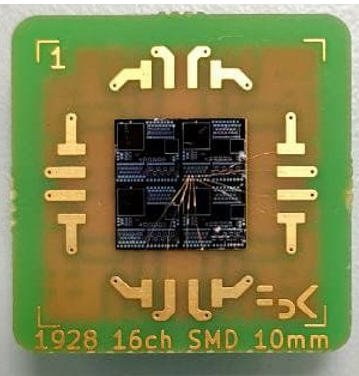
Figure 8. Top view picture of a produced sample after the integration on a printed circuit board (PCB).